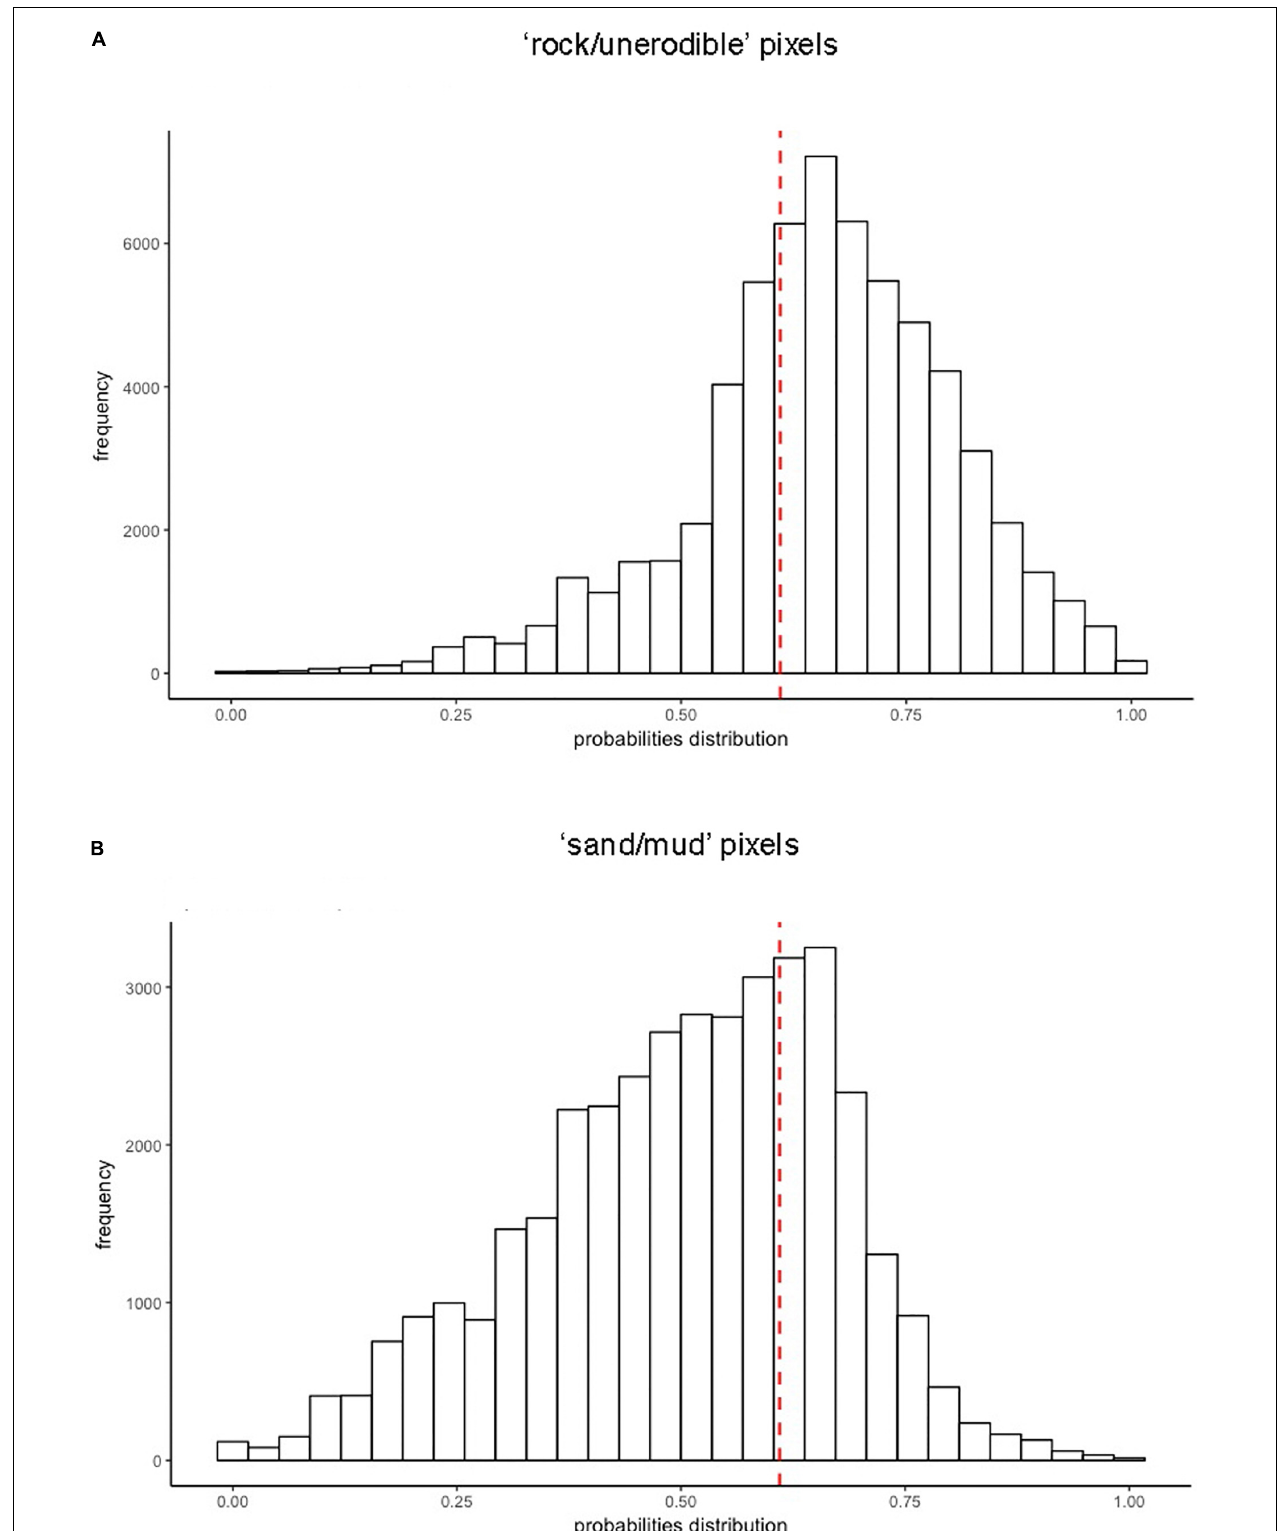
FIGURE 7 | Distribution RF output values for “no-data” records, grouped on the basis of the type of coastline: (A) “rock/unerodible” pixels; (B) “sand/mud” pixels. Red dashed lines represent the optimal cut-off ( t = 0.61).